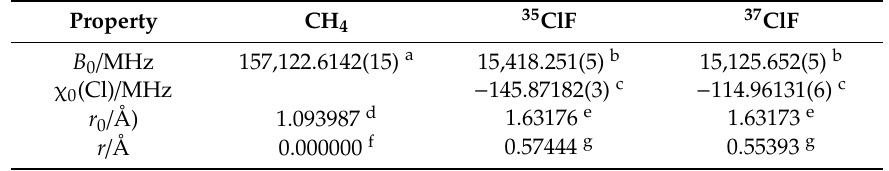
Table 4. Some properties of CH 4 and